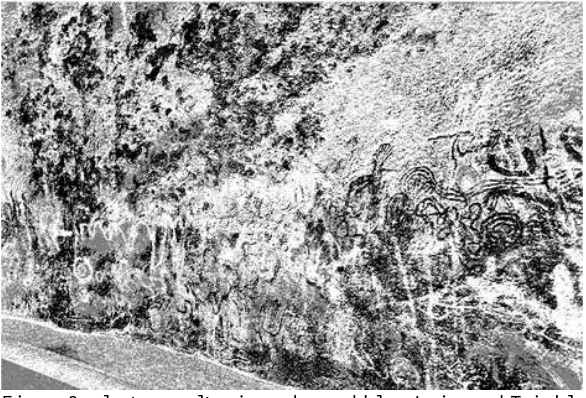
Figure 3: cluster result using enhanced blue, Leica and Trimble bands